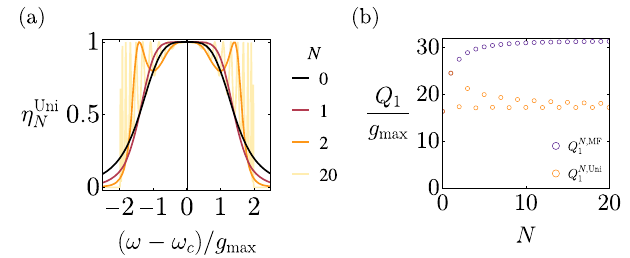
Fig. 3 | Diagrams for N -stage quantum transducers with uniform couplings. a Optimal ef fi ciency function η Uni N ½ ω (cid:2) for N -stage transducers with uniform cou- plings. b Continuous-time one-way pure-loss quantum capacities of N -stage maxi- mally fl at transducers Q N ,MF 1 (purple) and uniform transducers Q N ,U ni 1 (orange).